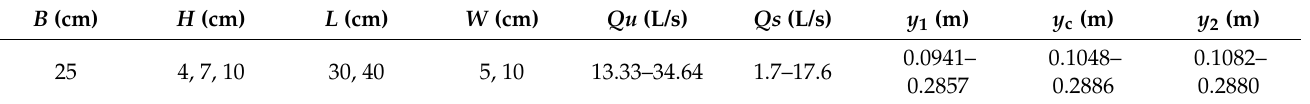
Table 1. Range of experimental data used in this research